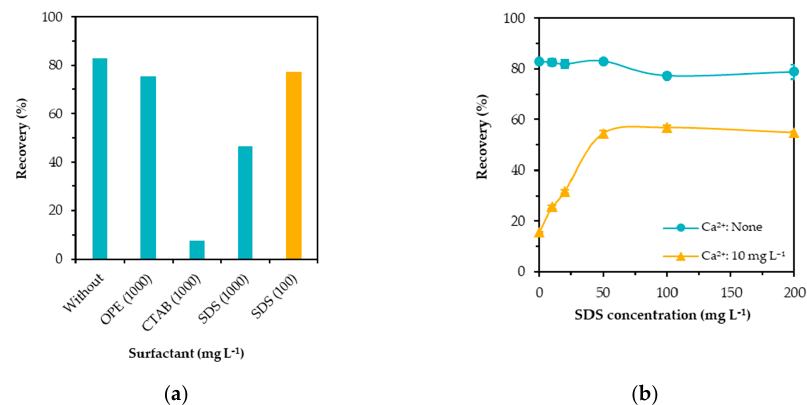
Figure 2. Effect of ( a ) various surfactants (1000 mg·L − 1 ) and ( b ) SDS concentrations on recovery of cadmium ions. Experimental conditions: Cd 10 µg·L − 1 ; AC 50 mg; pH 5; sample volume 200 mL; flow cadmium ions. Experimental conditions: Cd 10 µ g · L − 1 ; AC 50 mg; pH 5; sample volume 200 mL; rate 1 mL·s − 1 ; eluent 0.1 mol·L − 1 HNO 3 3 mL. flow rate 1 mL · s − 1 ; eluent 0.1 mol · L − 1 HNO 3 3